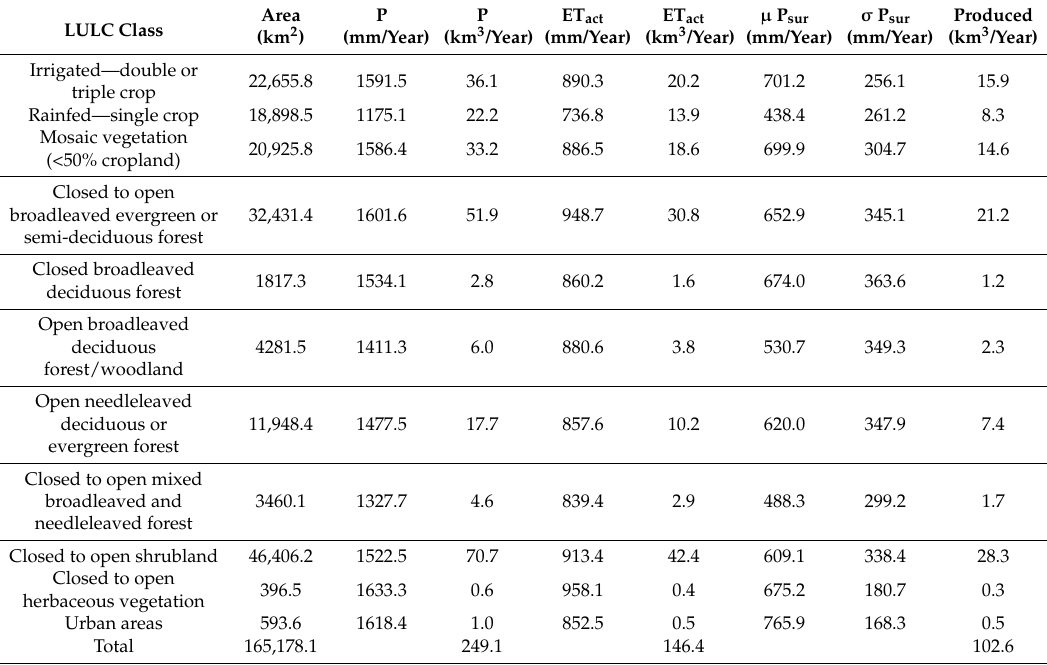
Table 6. Overview of consumptive use and water production per LULC class in the Red River Basin for the period